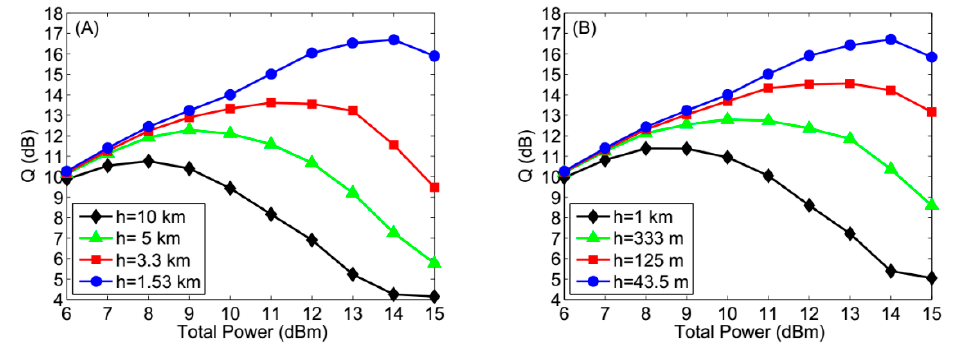
Figure 9. Received Q factor for channel spacing is 100 GHz with ( A ) XPM compensation and ( B ) XPM + four-wave mixing (FWM) compensation.